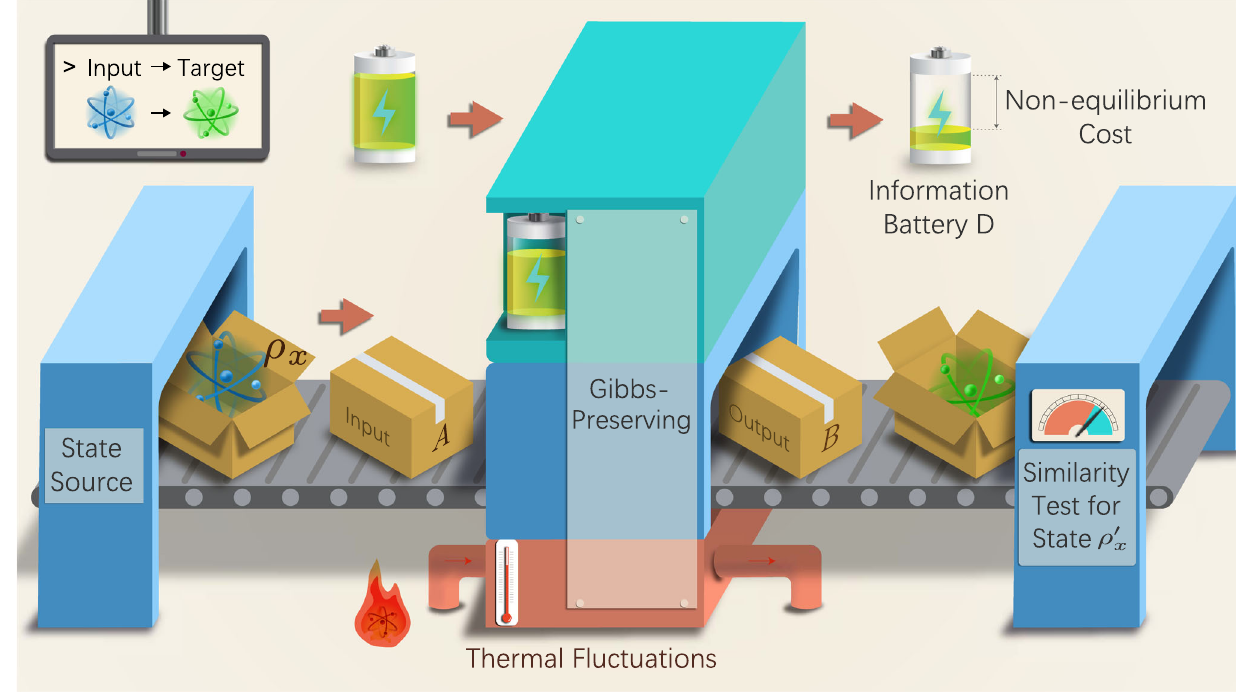
Fig. 1 | The nonequilibrium cost of accuracy. A source generates a set of input states for an information-processing machine. The machine uses an information battery(asupplyofqubitsinitialisedina fi xedpurestate)andthermal fl uctuations (areservoirintheGibbsstate)totransformtheinputstate ρ x intoanapproximation